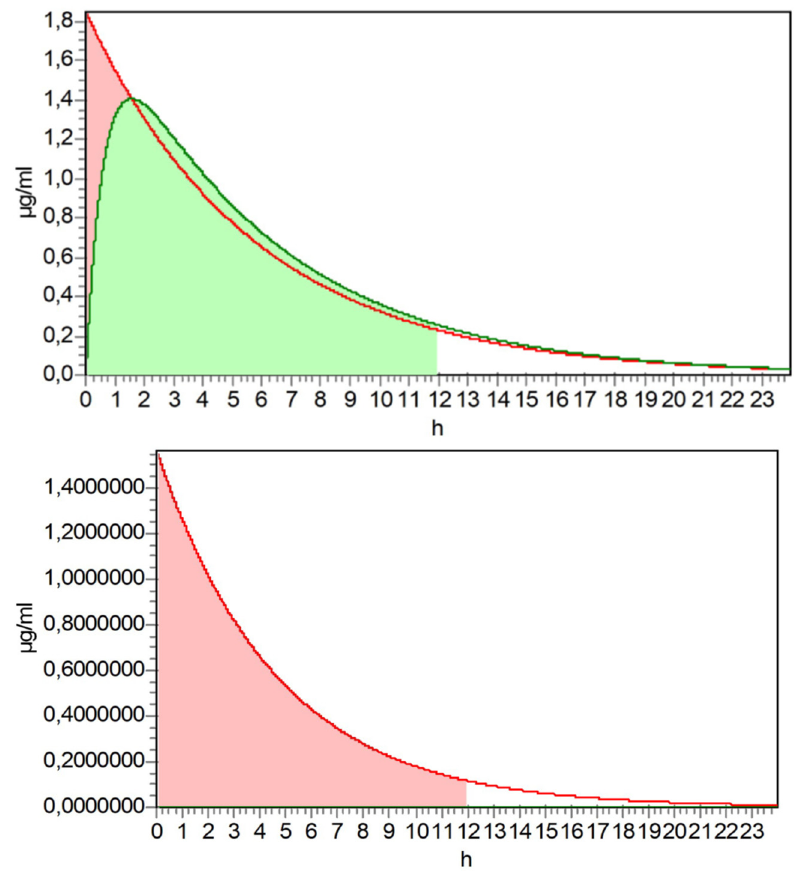
Figure 19. Pharmaceutical biodistribution for ligand L1 and complex C1 .